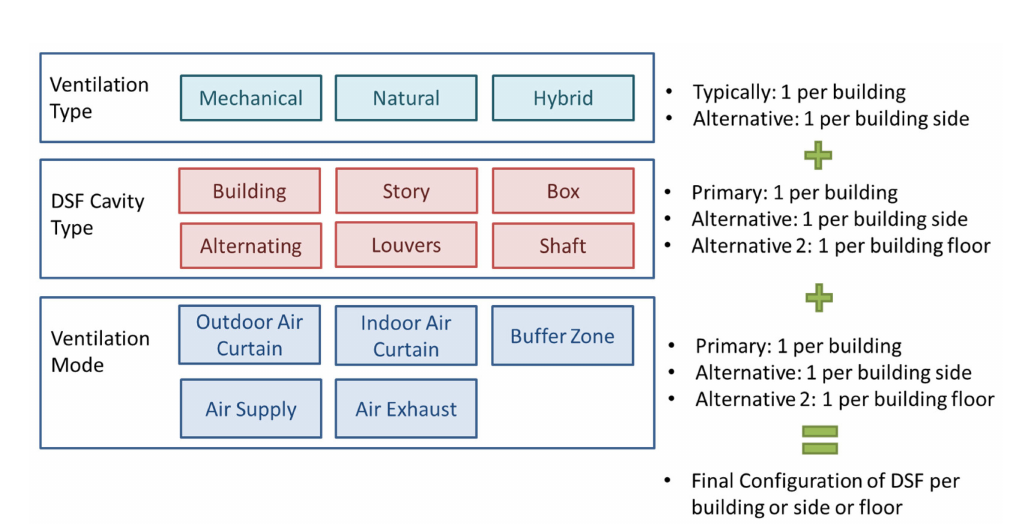
Figure 3. Possible Combinations of Different DSF